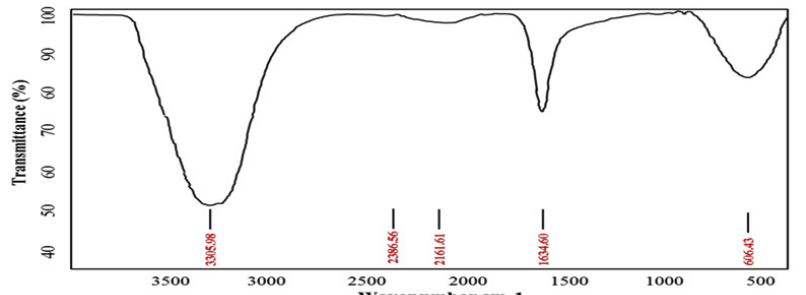
Fig. 3. FT-IR analysis of silver nanoparticles synthesized by Pseudomonas sp . H64